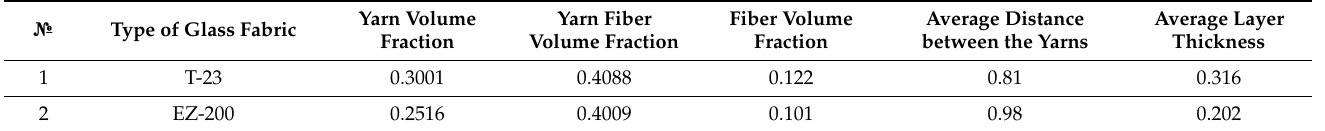
Table 5. Geometric structure parameters for EZ-200 and T-23 glass fabrics.